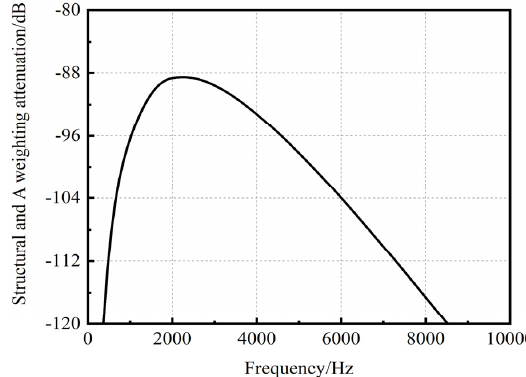
Figure 4. Structure and A-weighting attenuation.